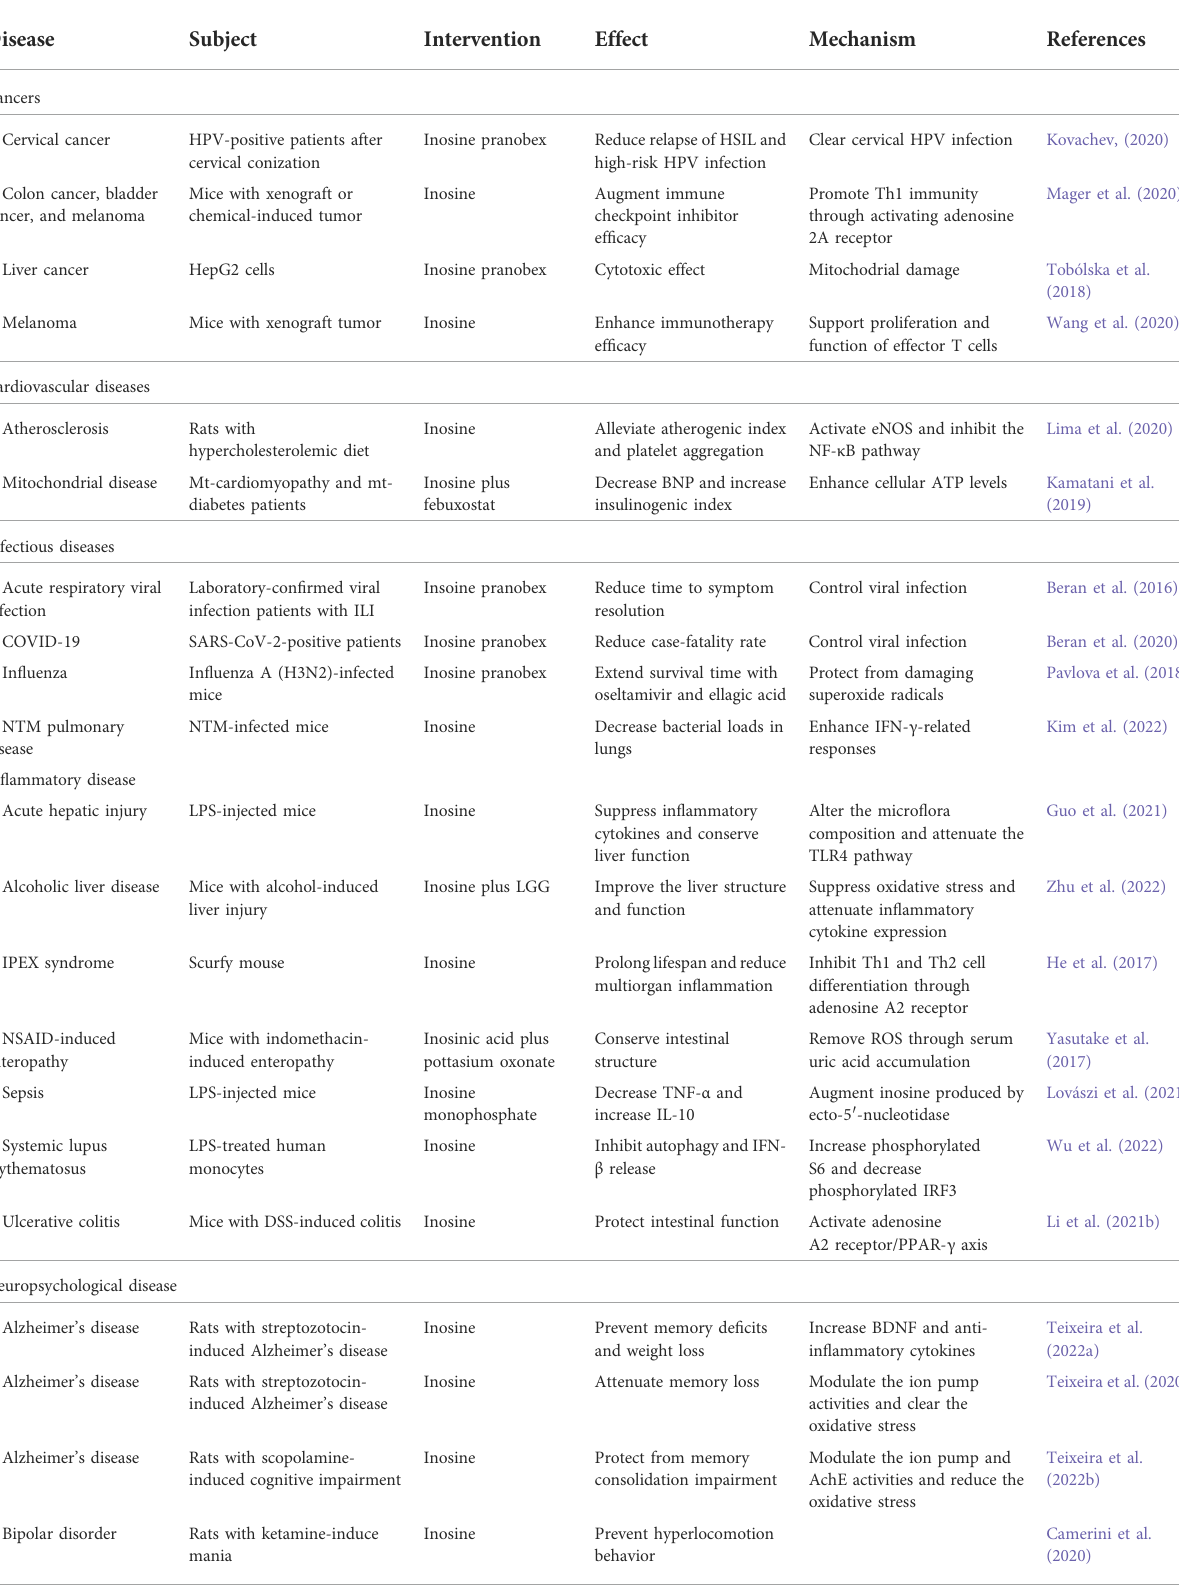
TABLE 1 Recent studies on inosine effects across various